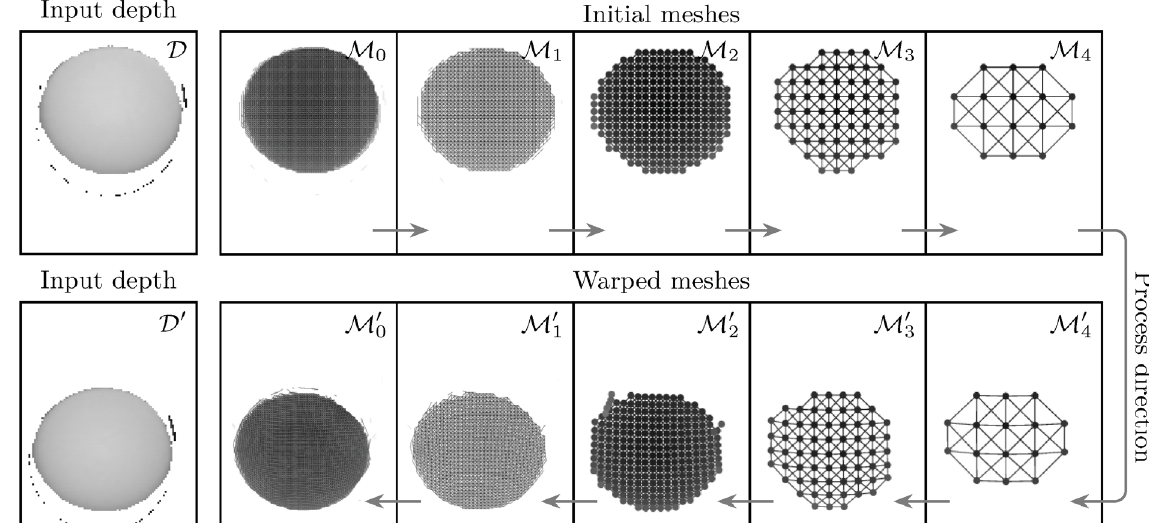
Fig. 3 Scene flow estimation using a rapidly moving spherical object. Mesh M 0 is generated from input D and is transformed through a series of steps, resulting in mesh M (cid:2) 0 , which closely matches the second input depth map D (cid:2) .